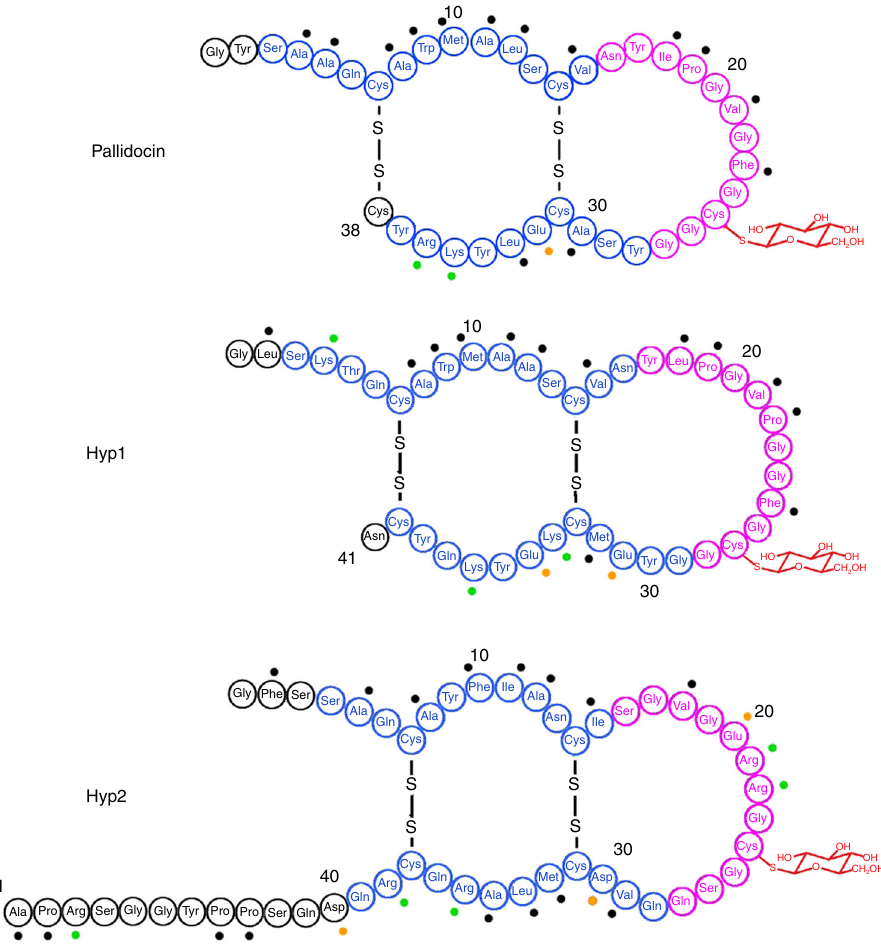
Fig. 2 Proposed structures of pallidocin, Hyp1 and Hyp2 glycocins based on PSIPRED predictions from the sequence and the known tertiary structure of sublancin 168 and GccF. α -helical structure highlighted in blue color. Coil structure highlighted in purple. Black dots indicate hydrophobic amino acids. Orange indicates acidic amino acids, whereas green indicates basic amino acids